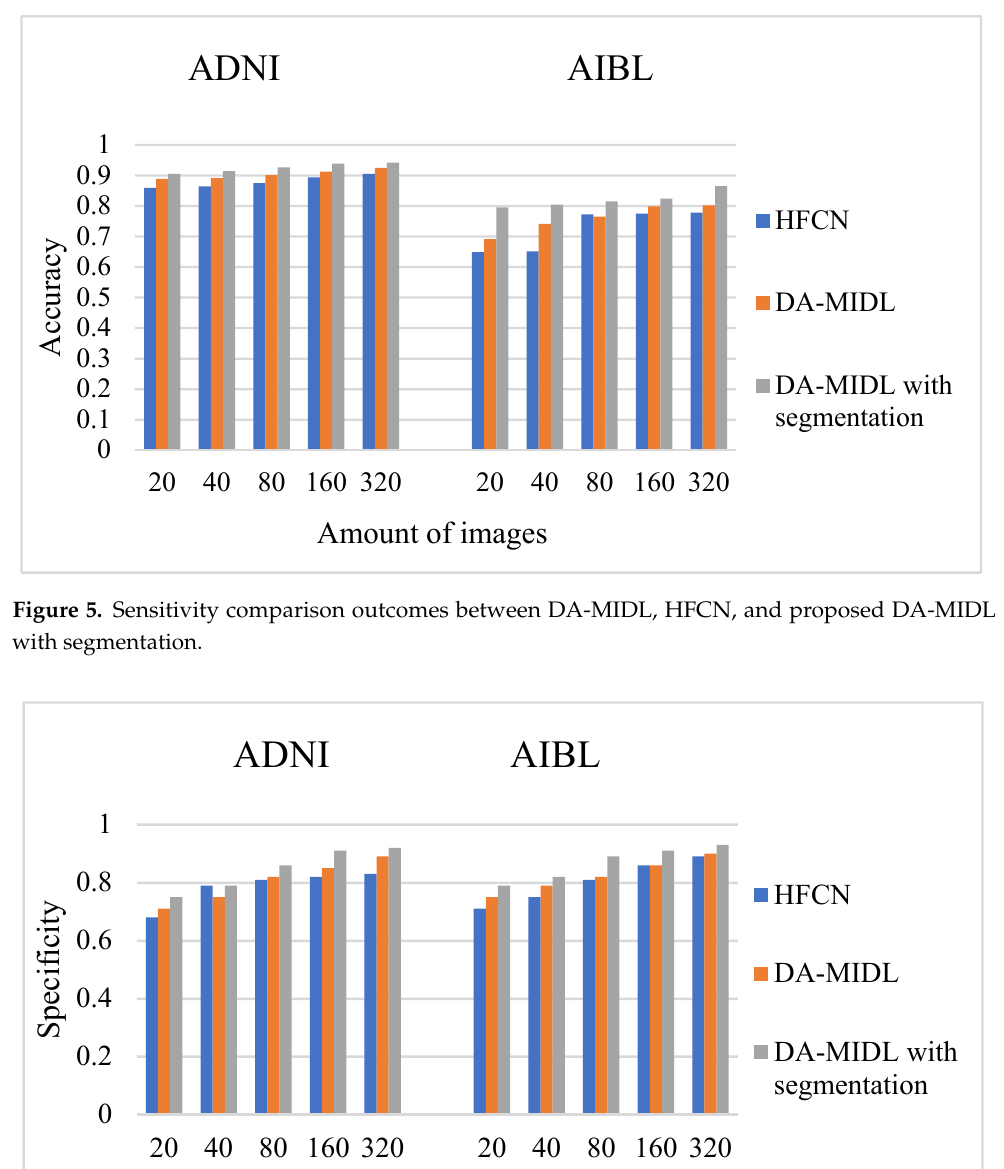
Figure 5. Sensitivity comparison outcomes between DA-MIDL, HFCN, and proposed DA-MIDL with segmentation.